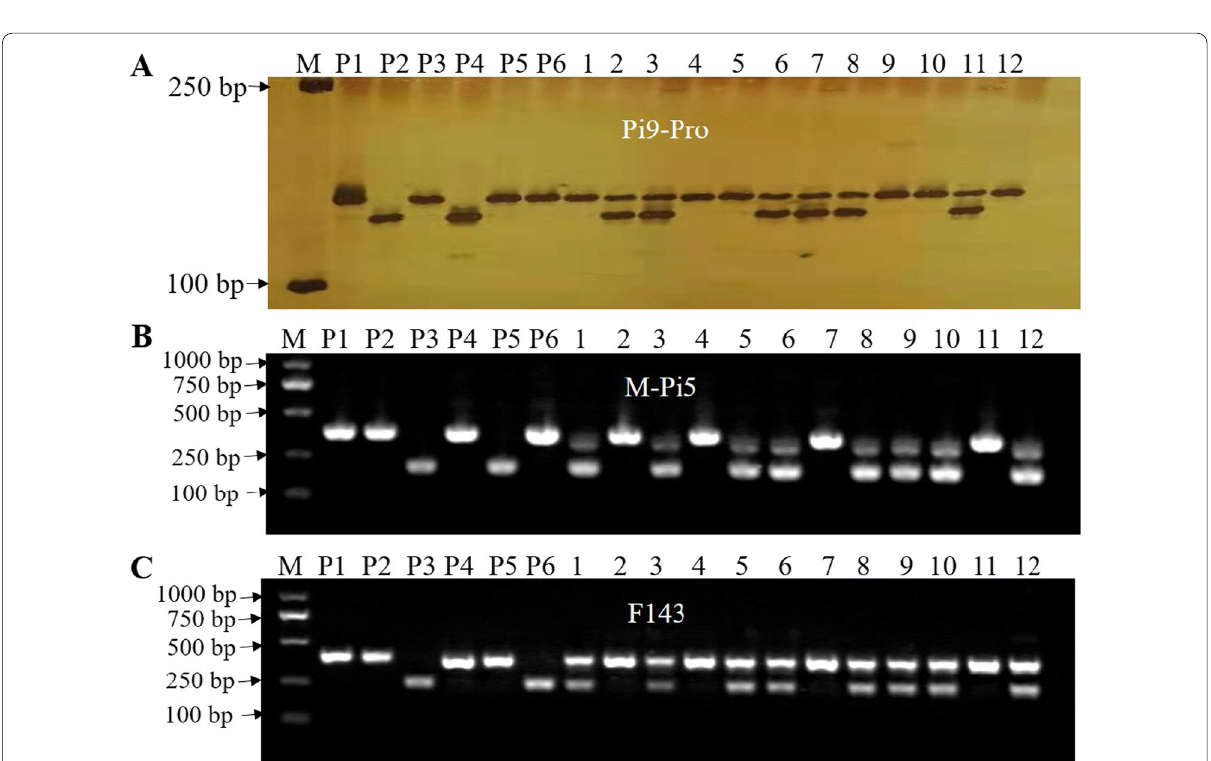
Fig. 2 Selection of heterozygote plants with three genes in F 1 population. A specific marker Pi9-Pro for Pi9 were fractionated on 6% polyacrylamide gel; B specific marker M-Pi5 for Pi5 were fractionated on 3% agarose gel; C specific marker F143 for Pi54 were fractionated on 3% agarose gel; M: 2000 bp DNA Marker; P1: Huhan 1S; P2: Huhan 1B(Pi9); P3: Huhan 91( Pi5 Pi54 ); P4: 75-1-127 ( Pi9 donor parent); P5: IRBL5-M ( Pi5 donor parent); P6: + IRBLkh-K3 ( Pi54 donor parent); lanes 1–12: 12 Plants of the F1